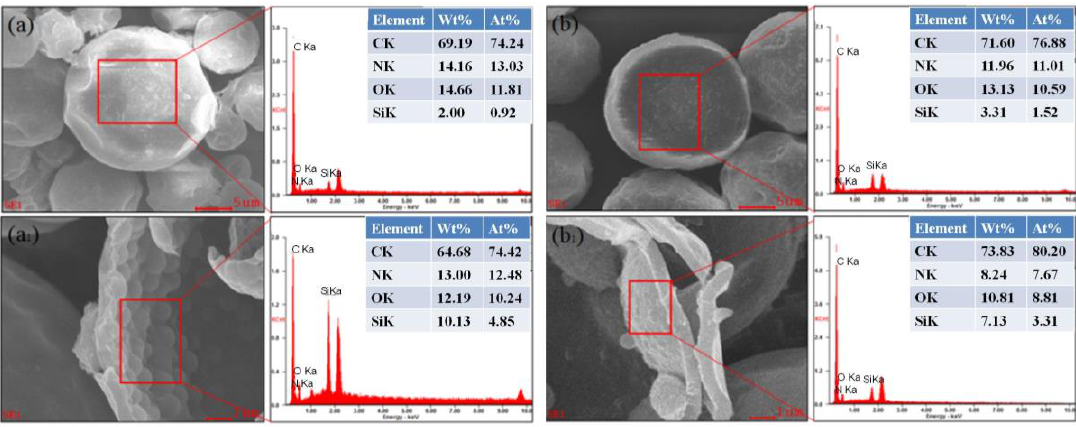
Figure 7. The EDS of ( a ) and ( a 1 ) polyurea–SiO 2 microcapsules; ( b ) and ( b 1 ) polyurethane–SiO 2 microcapsules.